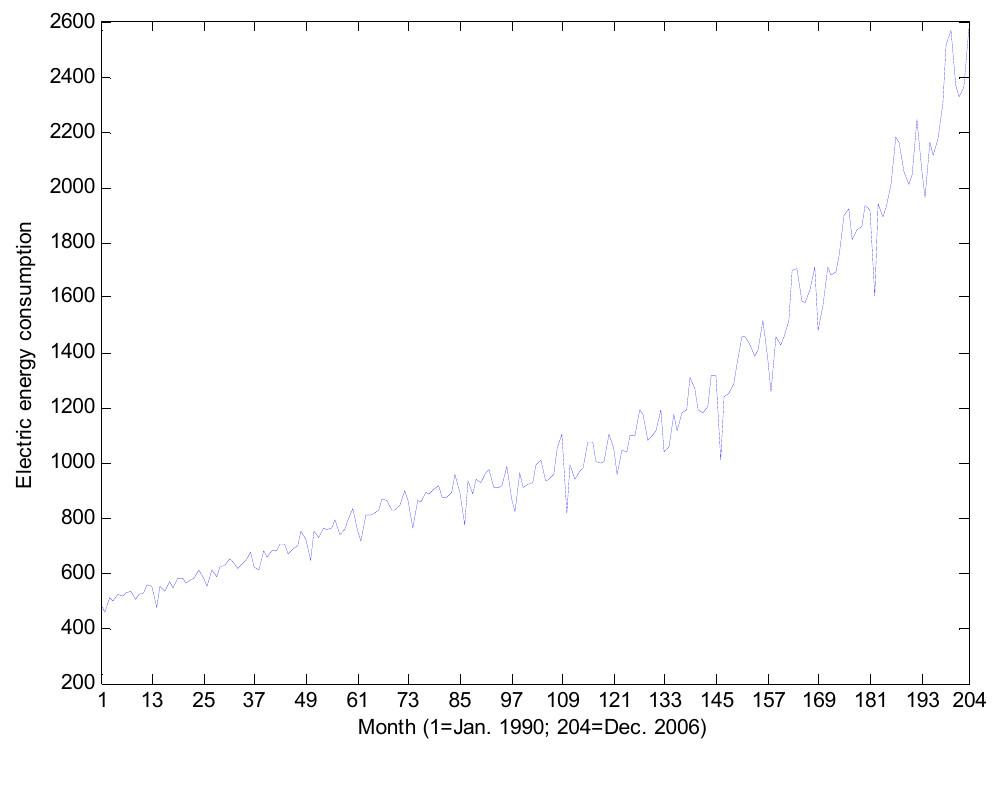
Figure 3. Monthly electricity consumption in China from January 1990 to December